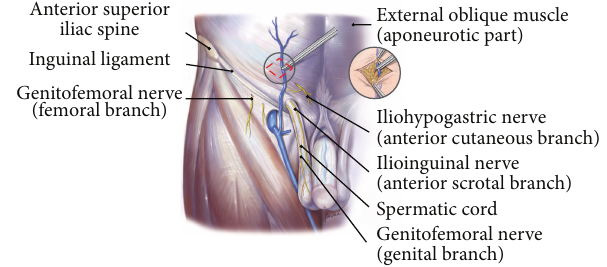
Figure 2: The superficial epigastric vein in the subcutaneous tissue layer is cauterized.